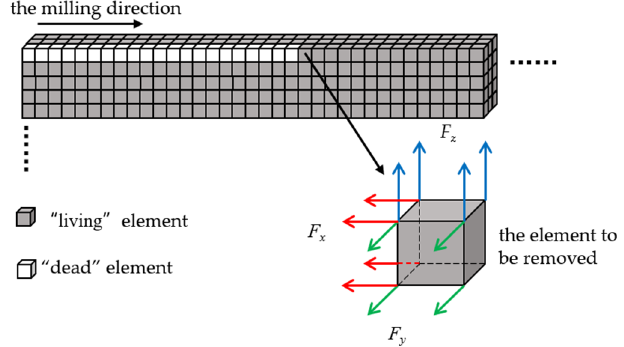
Figure 20. Simulation of the milling process with “birth-and-death element” technology.